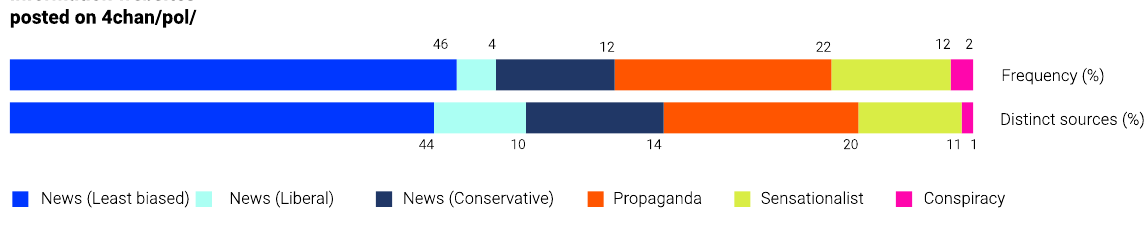
Figure 1. Categories of information websites shared on 4chan. Retrieved 25 March 2020; data source: 4CAT.